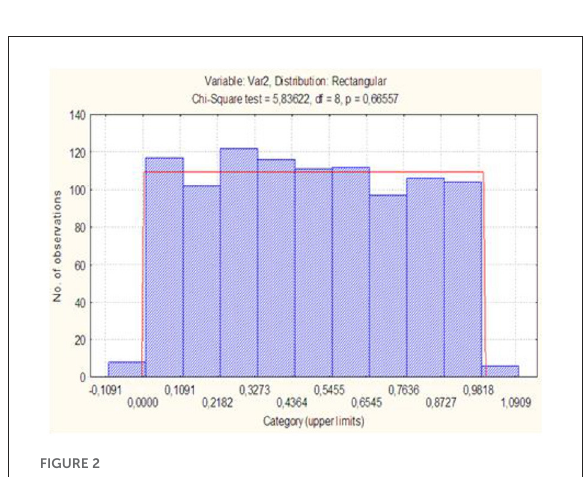
FIGURE2 Checking for the uniformity of a random variable υ = G (δ 2 )